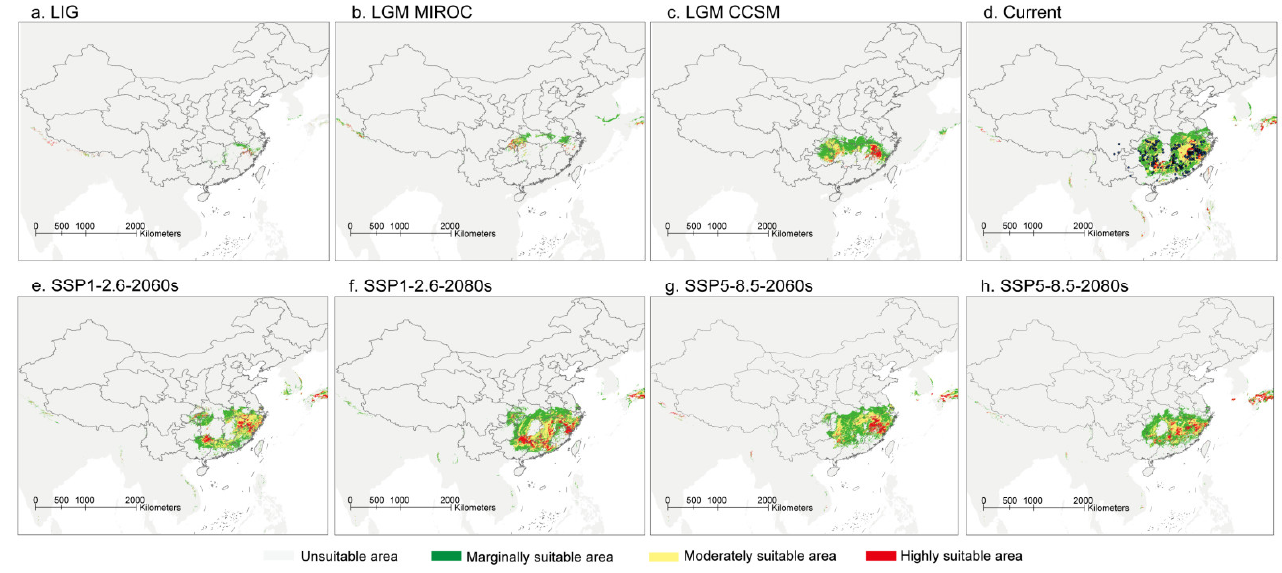
Figure 6. Prediction of potential distribution areas of A. cordatum in LIG ( a ), LGM MIROC ( b ), LGM CCSM ( c ), Current ( d ), SSP1-2.6-2060s ( e ), SSP1-2.6-2080s ( f ), SSP5-8.5-2060s ( g ), and SSP5-8.5-2080s ( h ) by MaxEnt. LIG: Last interglacial; LGM MIROC: Model for Interdisciplinary Research on Climate Earth System Model of the Last Glacial Maximum; LGM CCSM: Community Climate System Model of the Last Glacial Maximum. Table 3. Characteristics of potential distribution areas and distribution percentages during different periods for A. cordatum